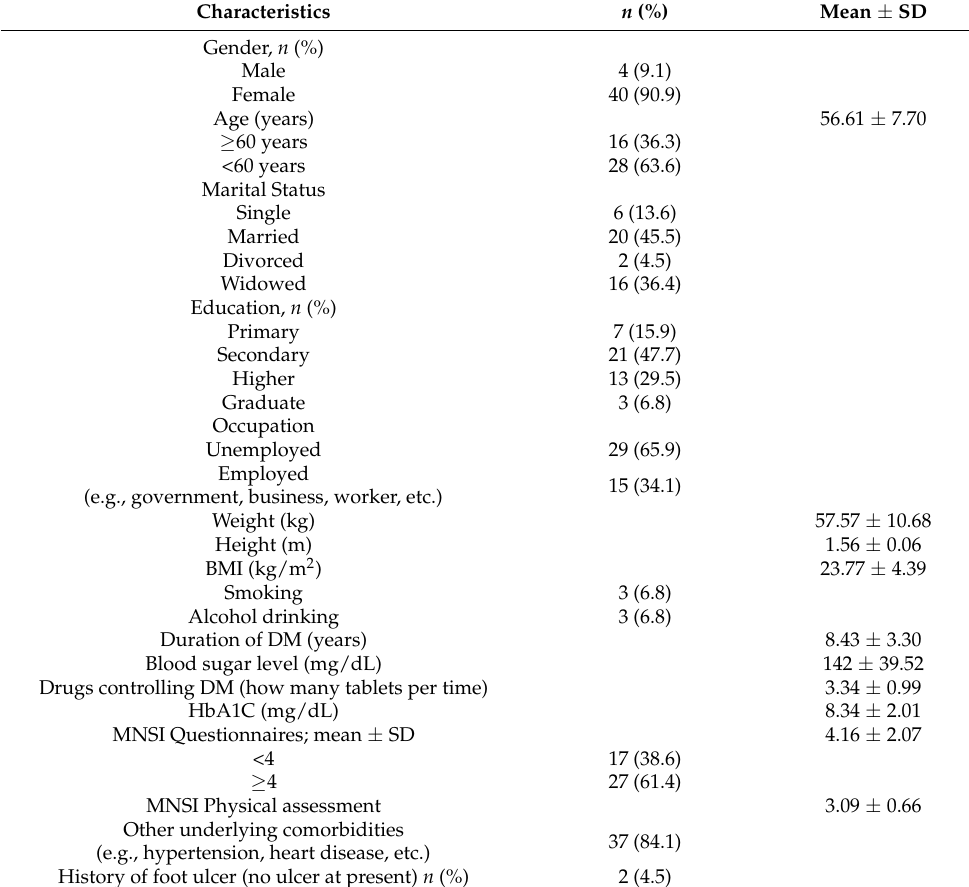
Table 1. Characteristics of the participants ( n = 44).